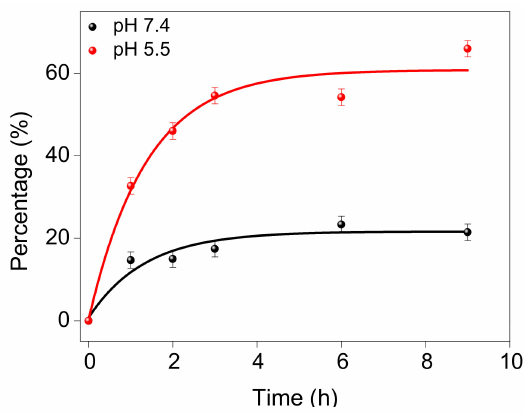
Figure 4. A plot of percentage of doxorubicin (DOX) released versus time at pH 5.5 and pH 7.4.